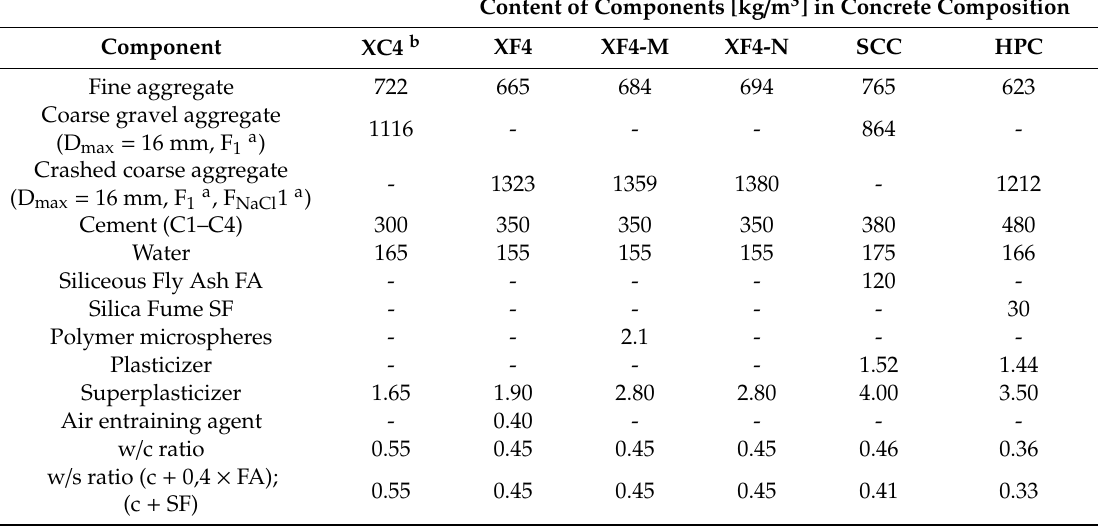
Table 5. Concrete mixture